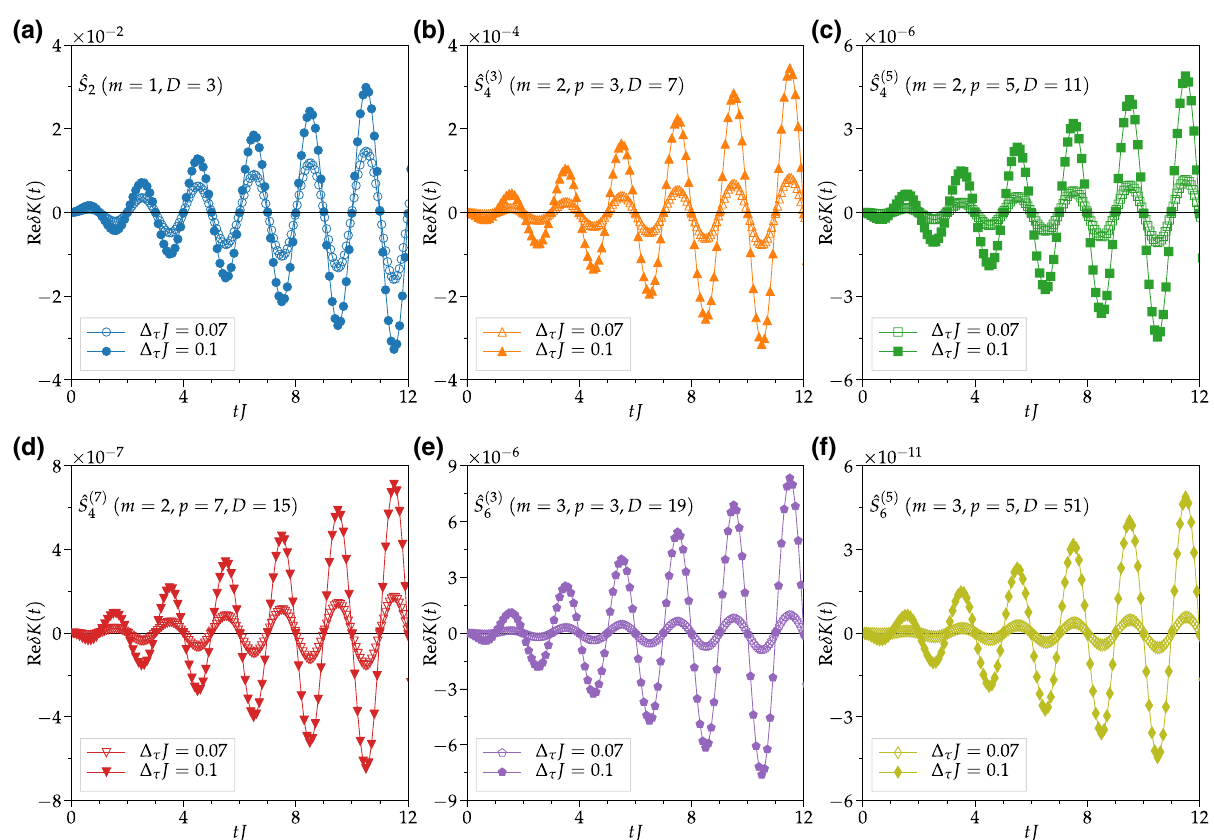
FIG. 16. Deviation of the real part of the propagator from the exact value, Re δ K ( t ) , for (cid:3) τ J = 0.07 (empty symbols) and (cid:3) τ J = 0.1 (filled symbols) with different approximation schemes of the symmetric Suzuki-Trotter decomposition operator. (a) m = 1, D = 3, (b) m = 2, p = 3, D = 7, (c) m = 2, p = 5, D = 11, (d) m = 2, p = 7, D = 15, (e) m = 3, p = 3, D = 19, and (f) m = 3, p = 5, D = 51, where D = D ˆ ( p ) ((cid:3) ) with m = 1 and p = 3. The results are for the spin-1/2 Heisenberg model on an N = 16 qubit ring described by to S τ 2 m